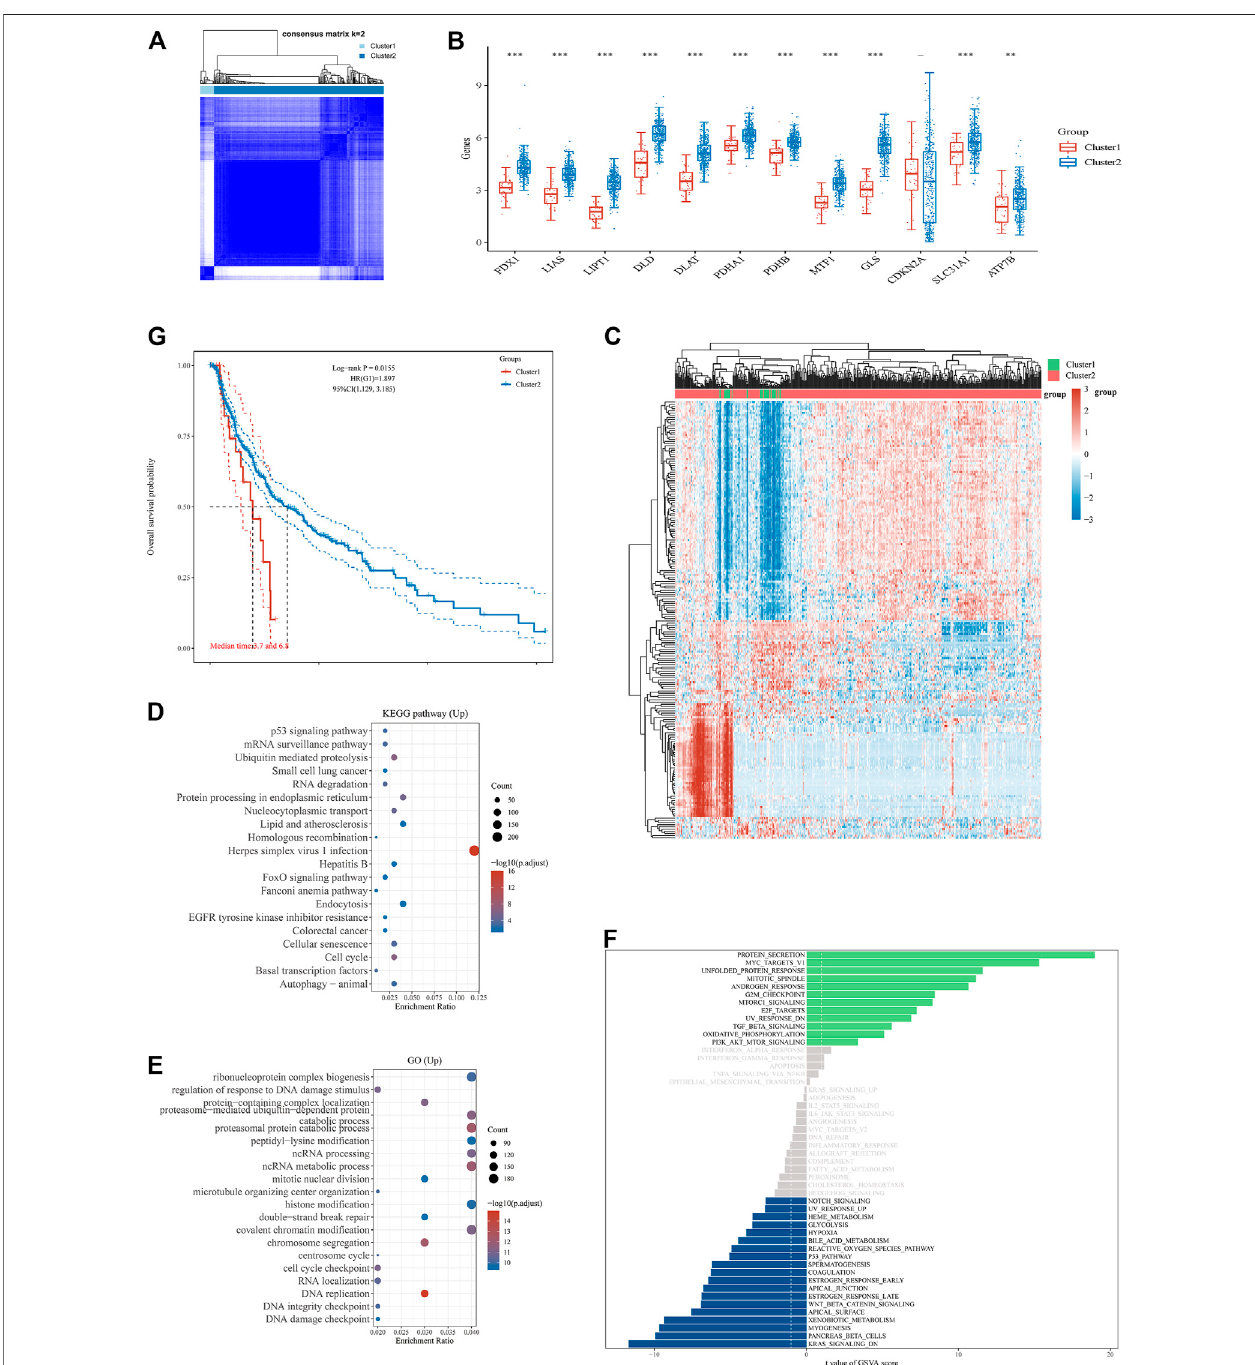
FIGURE2 | Differential expression pattern of cuproptosis-related genesand survival and functionalenrichmentanalysisin two Skin Cutaneous Melanoma (SKCM) clusters. (A) Consensusclusteringmatrixfork=2. (B) Boxplotsvisualizedtheexpressionpatternsofcuproptosis-relatedgenesintwoSKCMclusters. (C) Theheatmap of the differential gene expression between twoSKCM clusters. (D – F) The most signi fi cant KEGG pathways (D) , GO enrichment (E) and activation ofmultiple pathways by GSVA (F) in two SKCM clusters. (G) The Kaplan – Meier curves show the overall survival for two clusters of SKCM patients. ** p < 0.01, and *** p < 0.001.